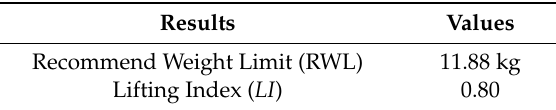
Figure 9. Example of lifting posture for handling flats filled with blueberries on an Oxbo 7240 blueberry harvester. Table 6. NIOSH lifting equation results for lifting task.